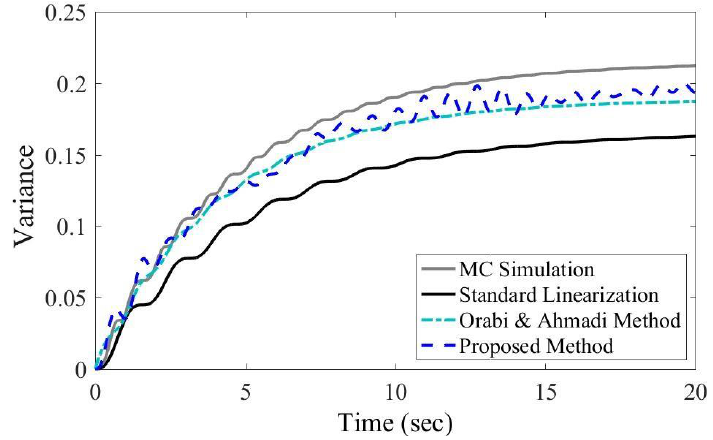
Figure 4. Mean square displacement response due to stationary excitation. ( γ = 10.0, μ = 1.0).